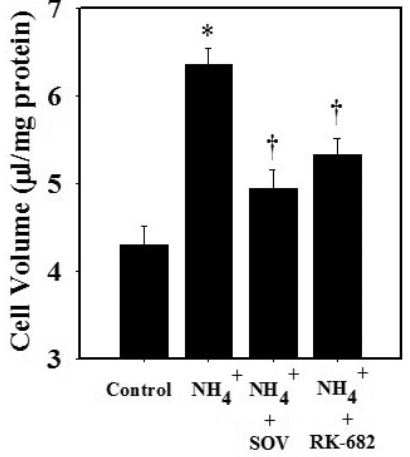
Figure 5. Effect of the protein tyrosine phosphatase (PTP) inhibitors (sodium orthovanadate and RK-682) on the ammonia-induced (NH 4 Cl; 5 mM) astrocyte swelling (24 h). PTP inhibitors (50 µ M SOV and 25 µ M RK-682) markedly reduced the cell swelling induced by ammonia. Data were subjected to ANOVA followed by Tukey‘s post hoc comparison test ( n = 4). * p < 0.05 vs. control † p < 0.05 vs. NH 4+ . Error bars, mean ± S.E. OSV, sodium orthovanadate.